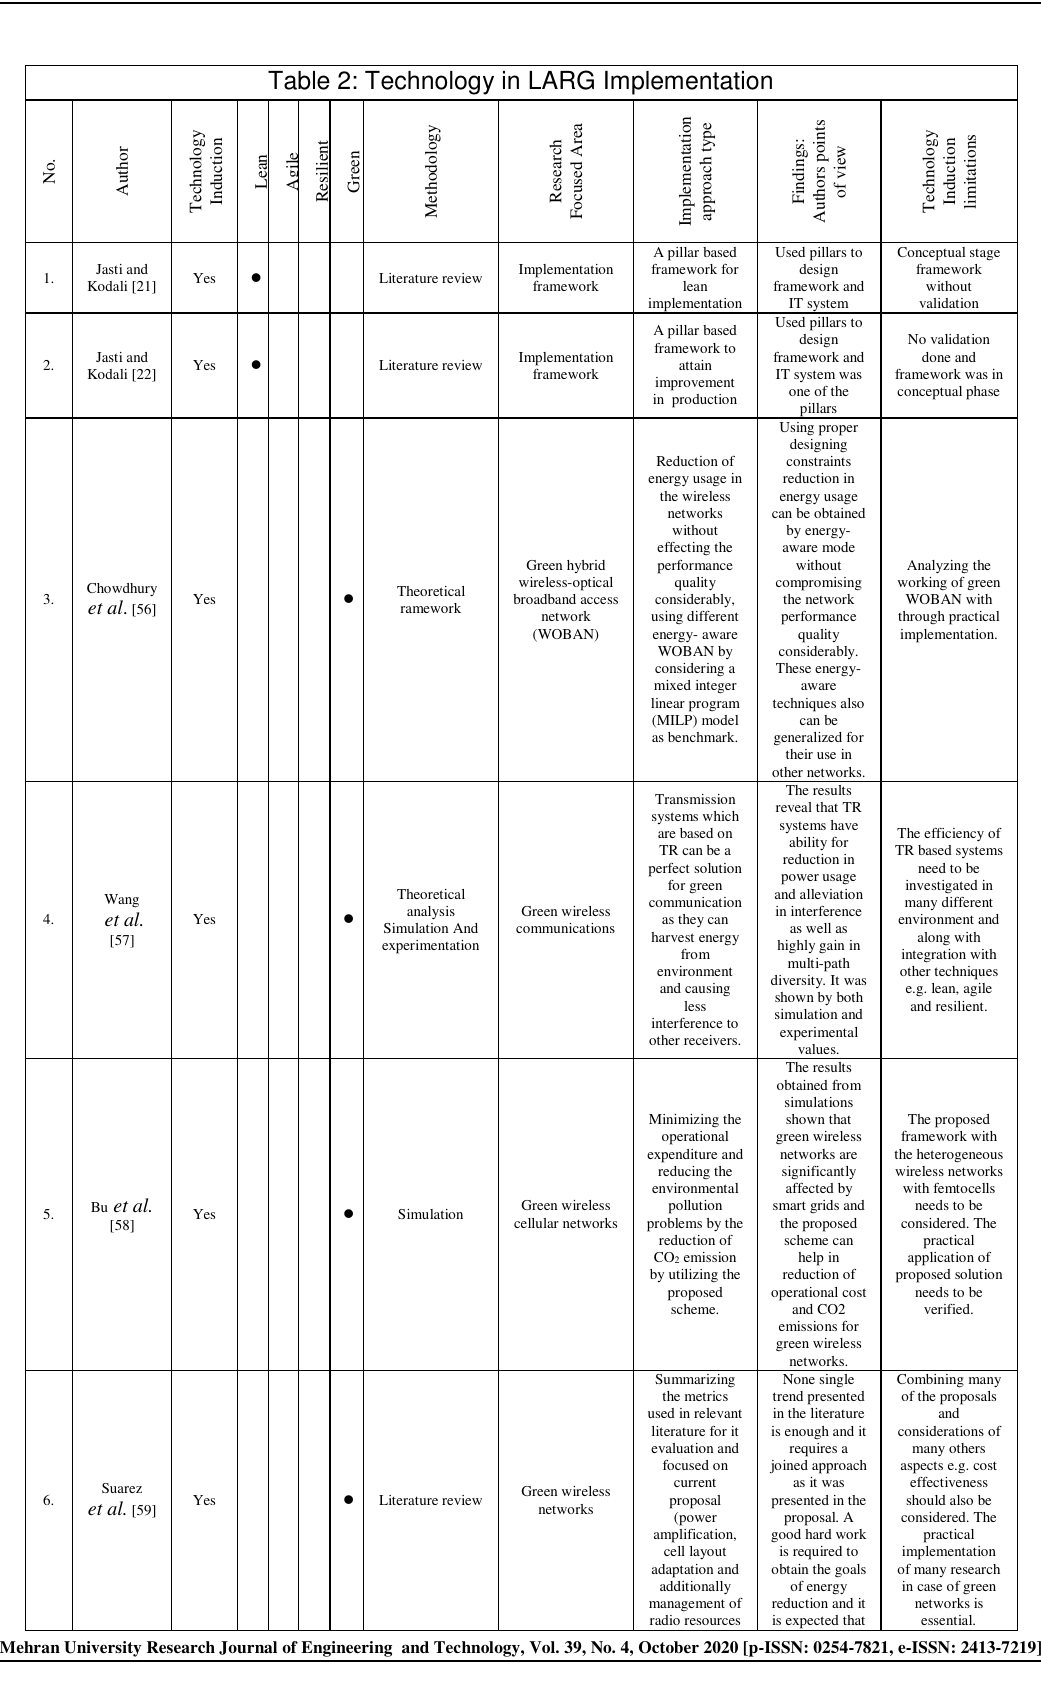
Table 2: Technology in LARG Implementation